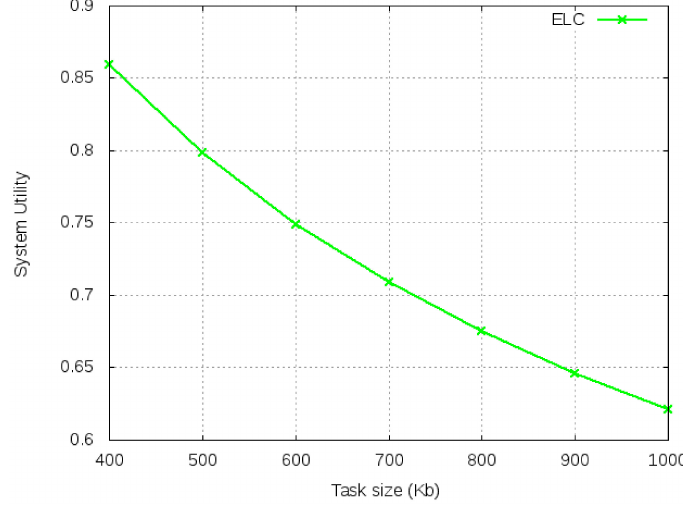
Figure 9. System utility for ELC with varied task size.